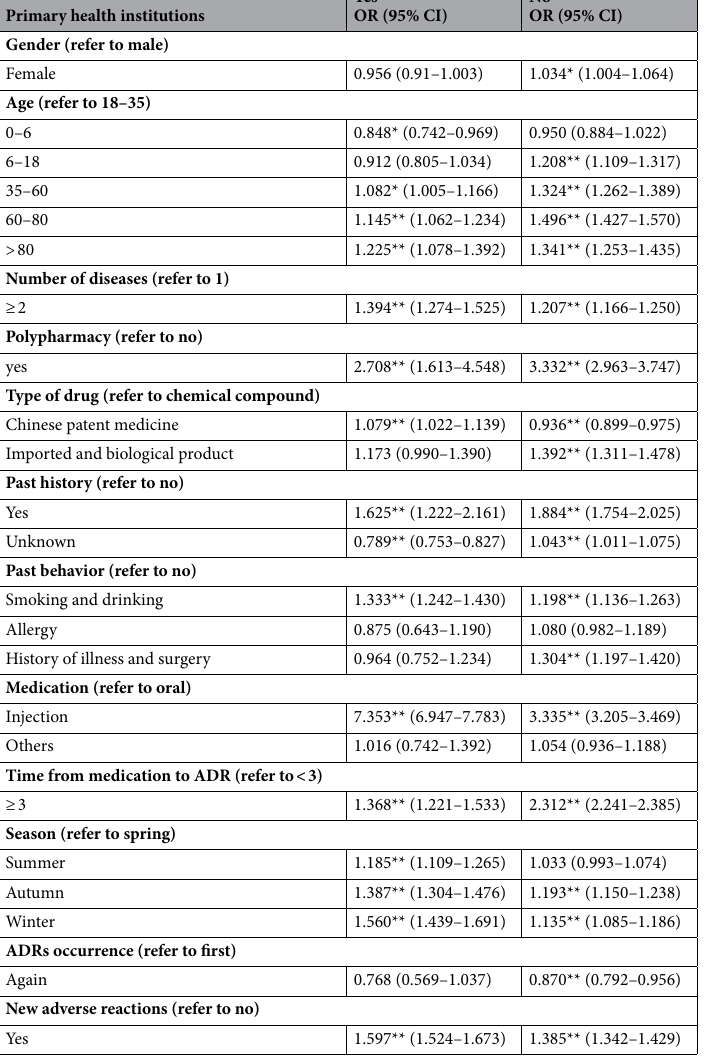
Table 3. SADRs in primary and non-primary medical